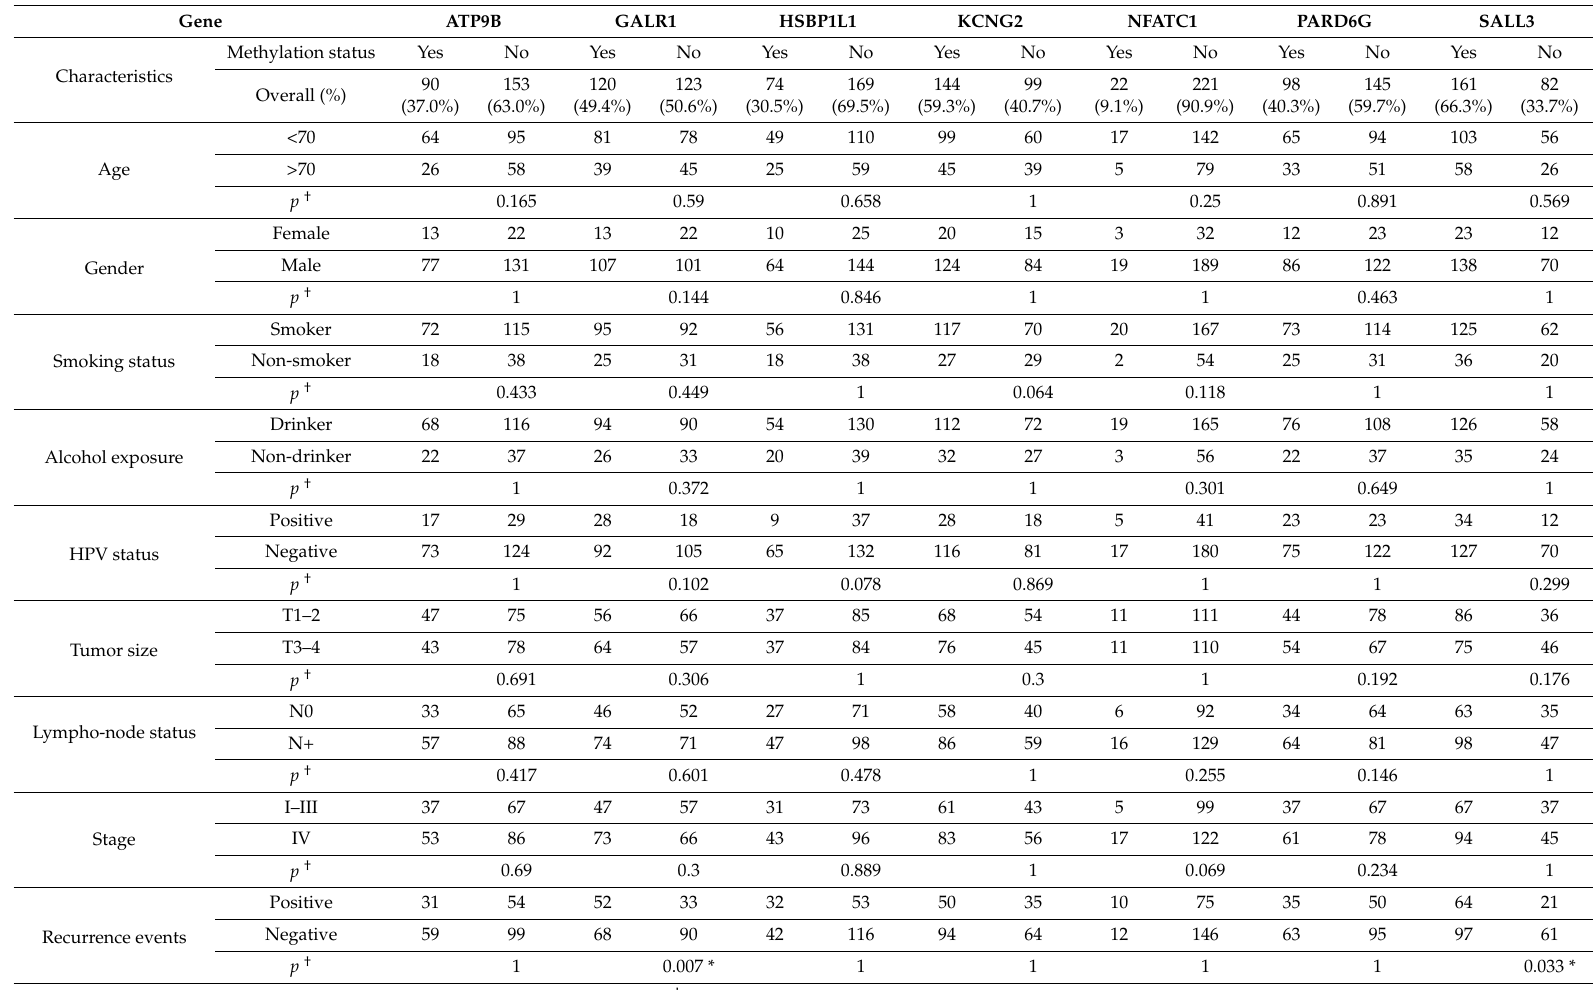
Table 1. Distribution of methylation status by selected epidemiologic and clinical characteristics in the original